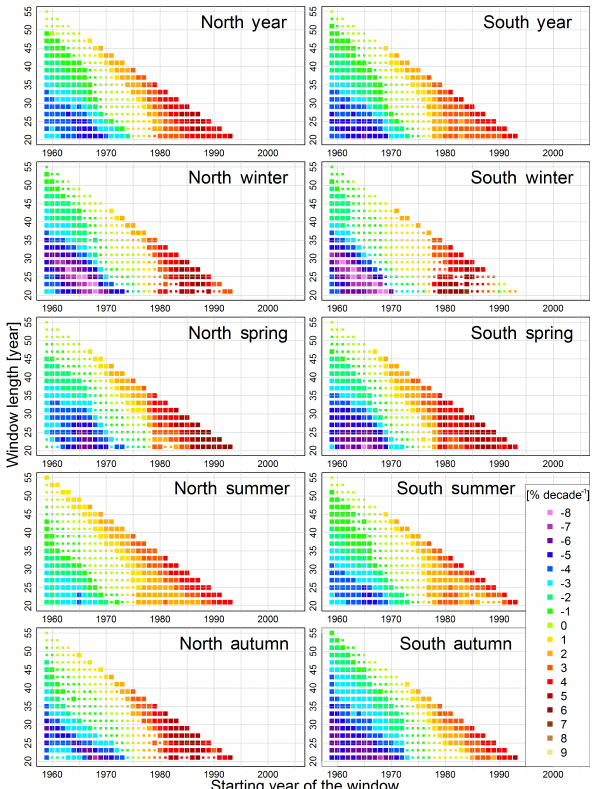
Figure 7. Running trend analysis for annual and seasonal northern (left column) and southern (right column) Italian SSR records ob- tained under clear-sky conditions (0okta of TCC as the threshold). The y and x axes represent the length and the first year of the period under analysis, respectively, while the colored pixels show the trend expressed in %decade − 1 with a significance level of p ≤ 0.1 (large squares) and p > 0.1 (small